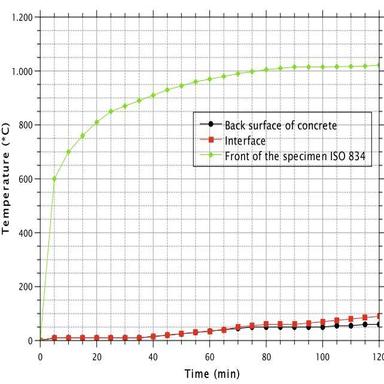
Performance of GeoSiCem-Foam under ISO-834 fire load curve.